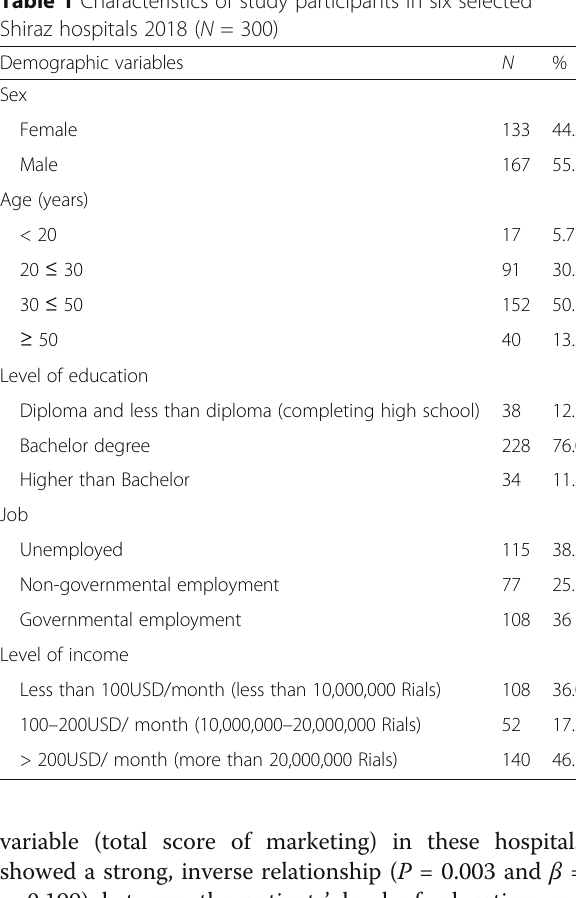
Table 1 Characteristics of study participants in six